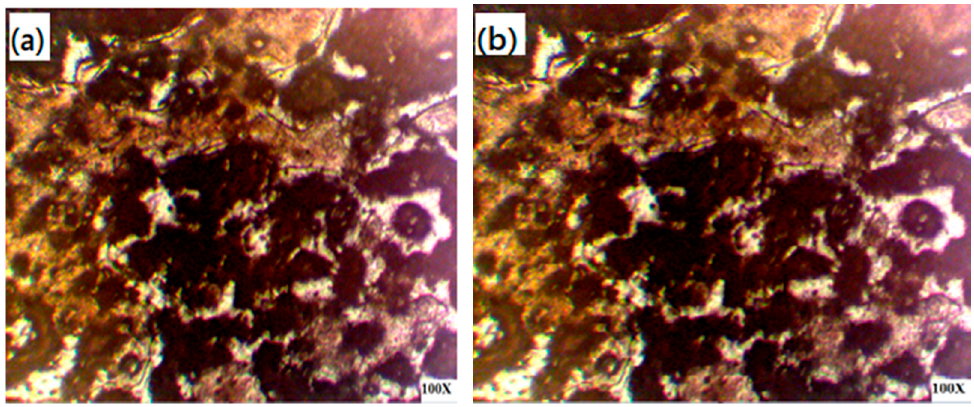
Figure 8. Optical micrograph of the weld zone: ( a ) with the magnetic field and ( b ) of the base metal [10].